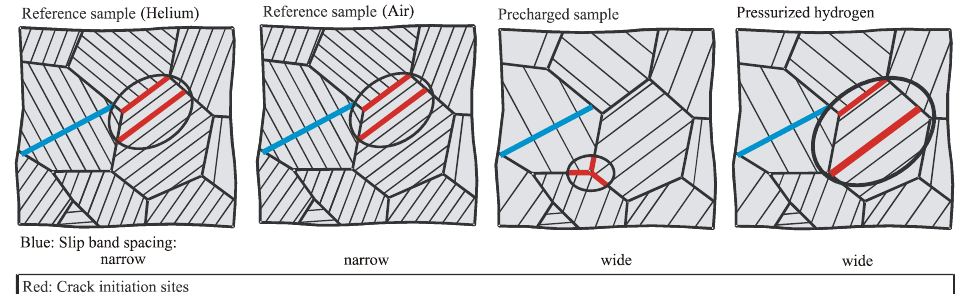
Figure 7. Crack initiation sites and slip band spacing in reference samples (pressurized helium and air), precharged samples and pressurized hydrogen samples.